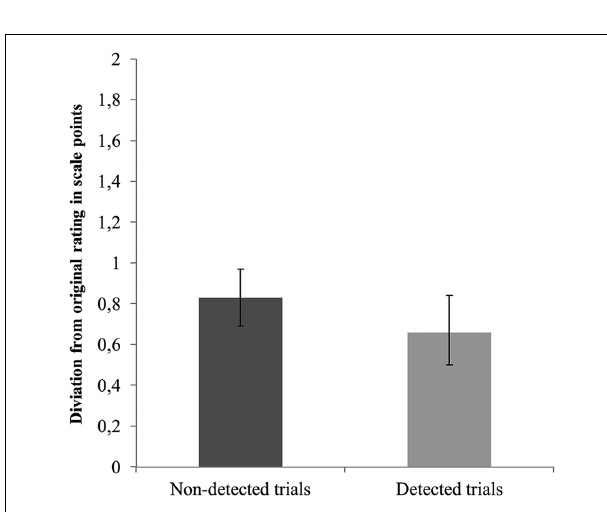
FIGURE 3 | Mean distance from the original sympathy rating as a function of detection (detected vs. non-detected). Error bars represent 95% confidence